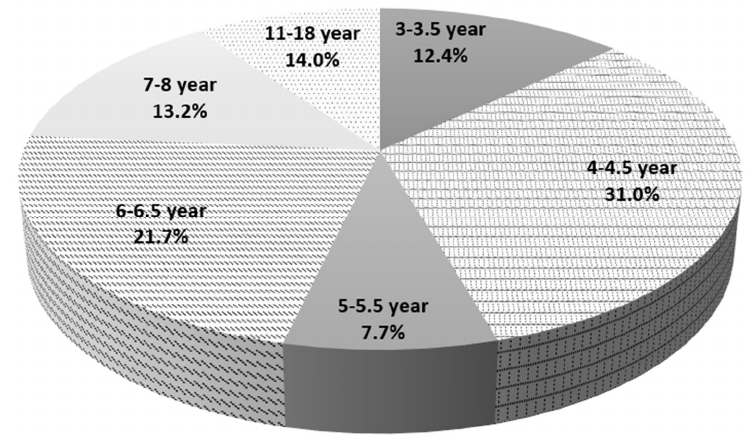
Figure 4. Age characteristics of study population.